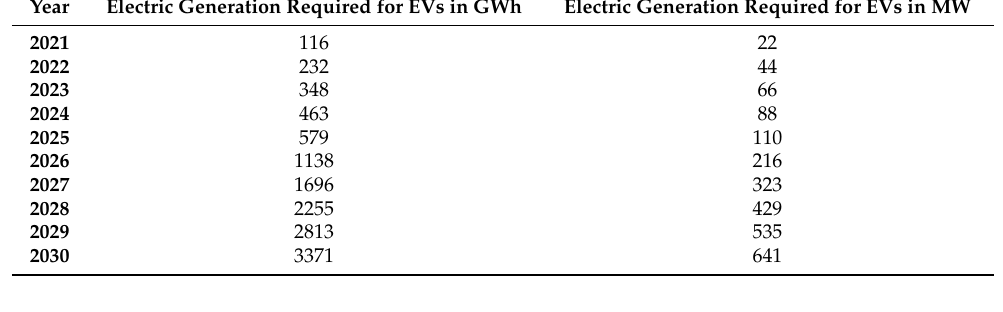
Table 4. Electricity generation for EVs: 2021–2030.